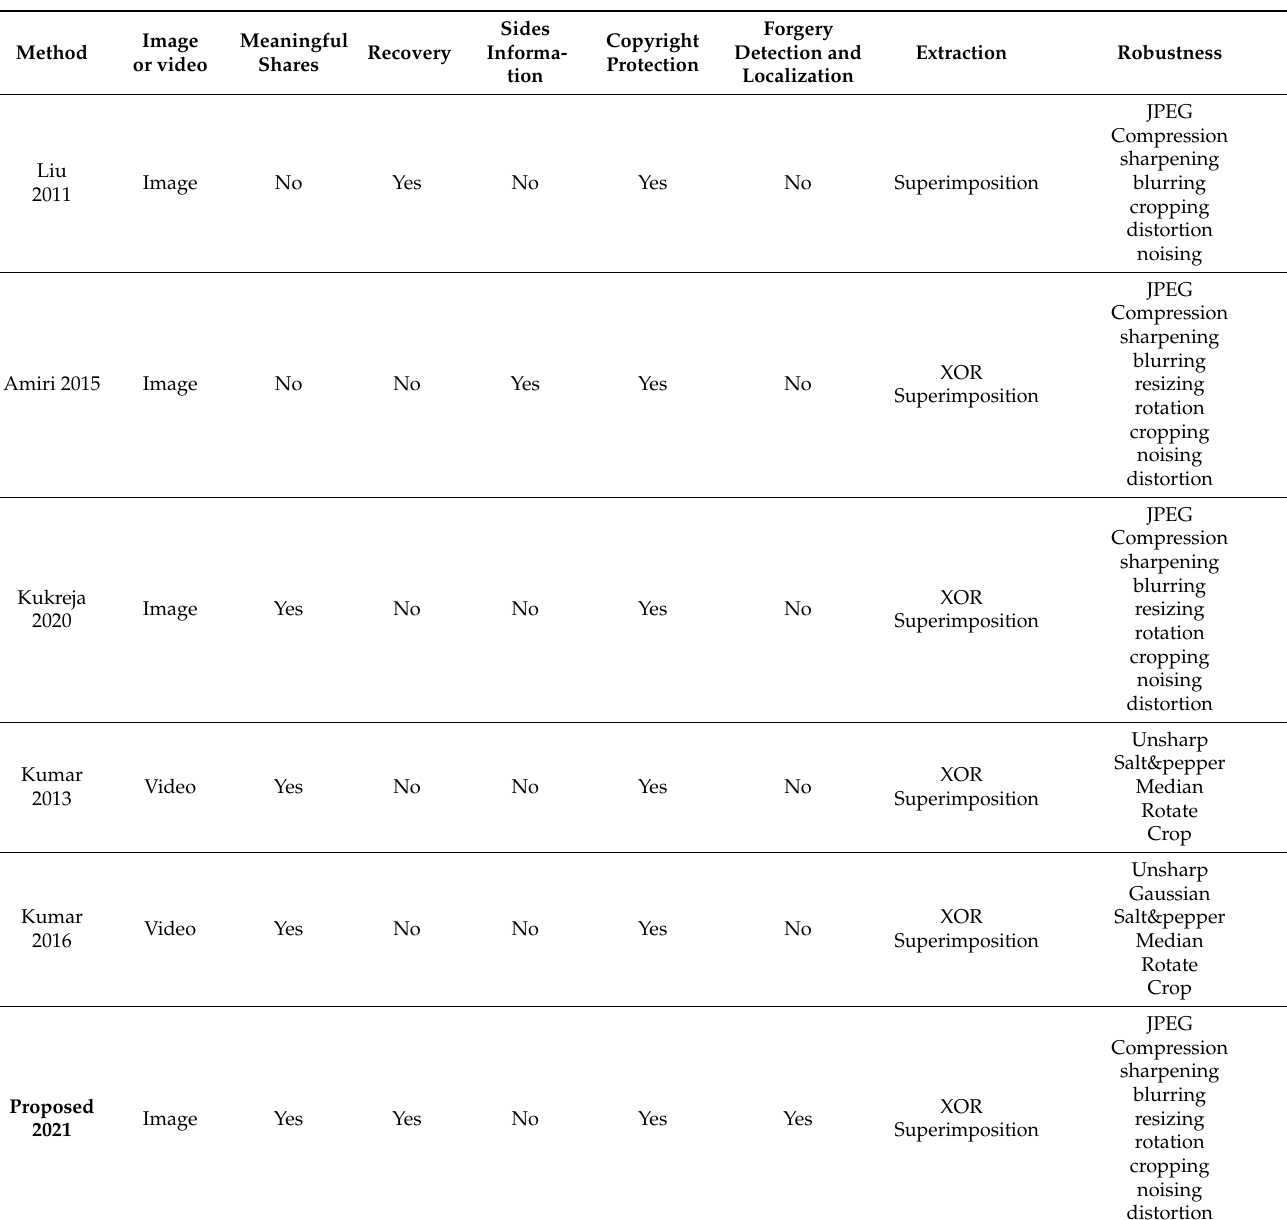
Table 6. Qualitative comparison of the proposed approach with the state-of-the-art